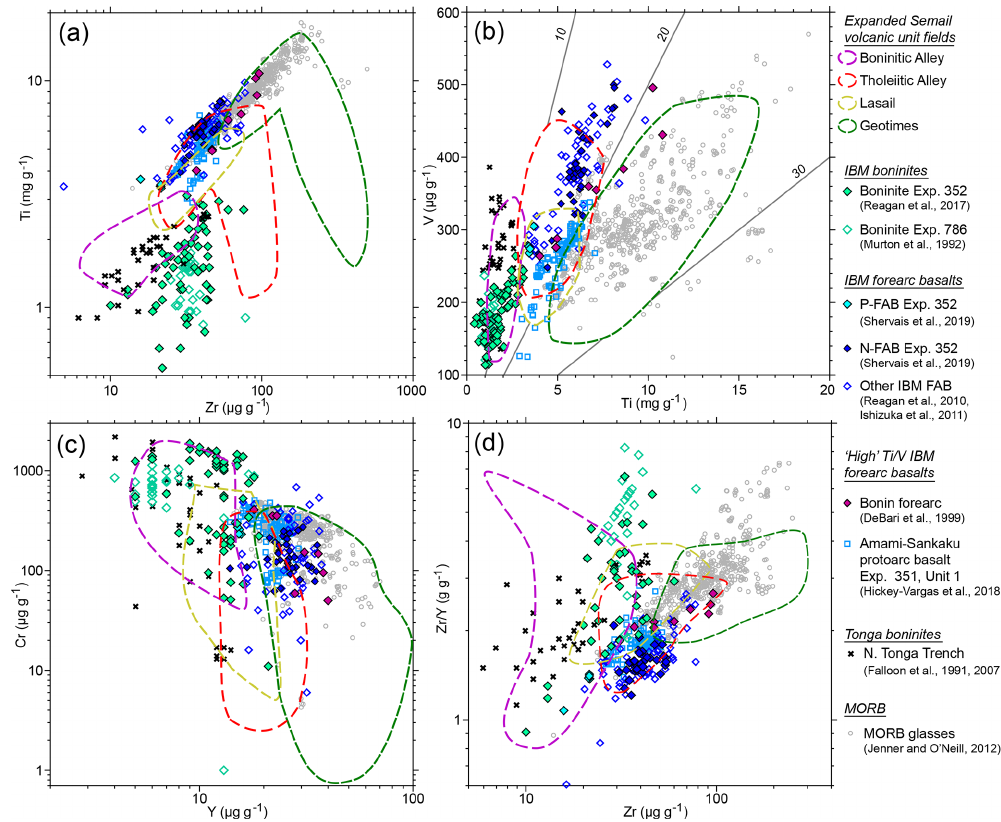
Figure 18. Comparison of the expanded Semail volcanic unit fields with Izu–Bonin–Mariana (IBM) proto-arc volcanic rocks, north Tonga Trench boninites and MORB glasses. West Pacific boninite analyses from N. Tonga Trench and N. Lau basin (Falloon et al., 2007; Falloon and Crawford, 1991), Izu–Bonin forearc (IODP Expedition 786; Murton et al., 1992), and Bonin forearc (IODP Expedition 352; Shervais et al., 2019). Normal Forearc Basalt (N-FAB) and Primitive Forearc Basalt (P-FAB) from Shervais et al. (2019) and other IBM forearc basalts (FAB) from Reagan et al. (2010) and Ishizuka et al. (2011). High Ti / V forearc basalts from DeBari et al. (1999) and Hickey-Vargas et al. (2018). MORB glasses from Jenner and O’Neill